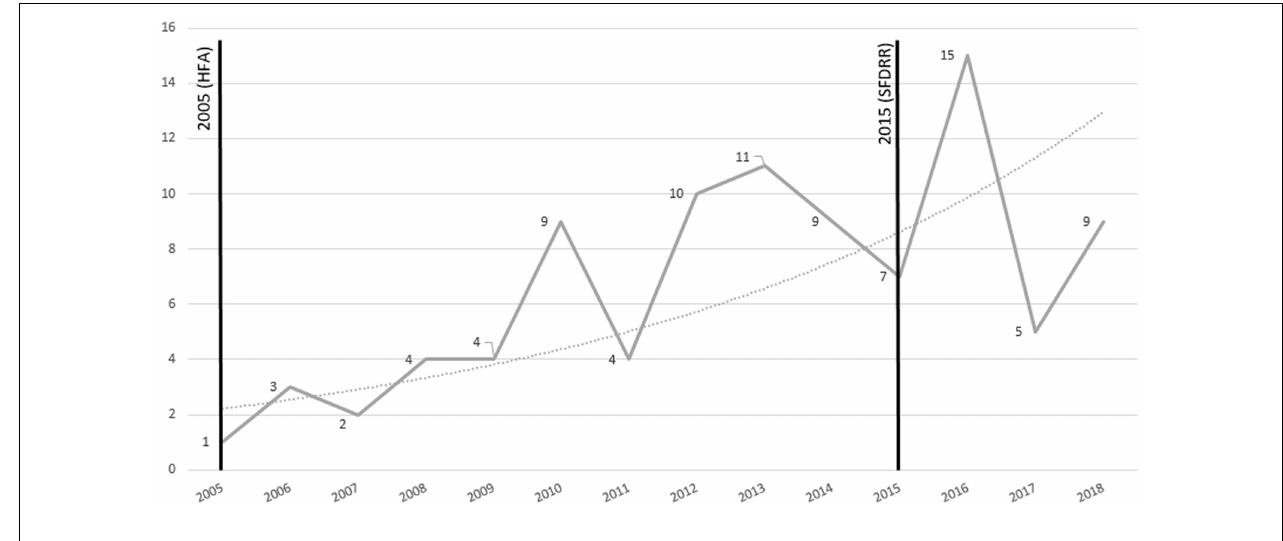
FIGURE 2 | Number of selected studies per